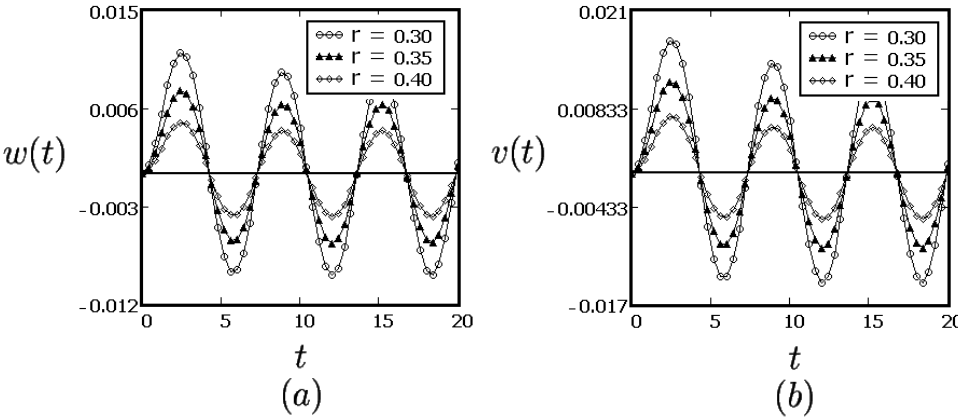
Fig. 4. Profiles of the velocity components w ( r , t ) and v ( r , t ) given by Eqs. (39), for R 1 = 0.3, R 2 = 0.5, f = g = −2, ω 1 = ω 2 = 1, ν = 0.1188, µ = 10.384, α = 0.2 and different values of r .